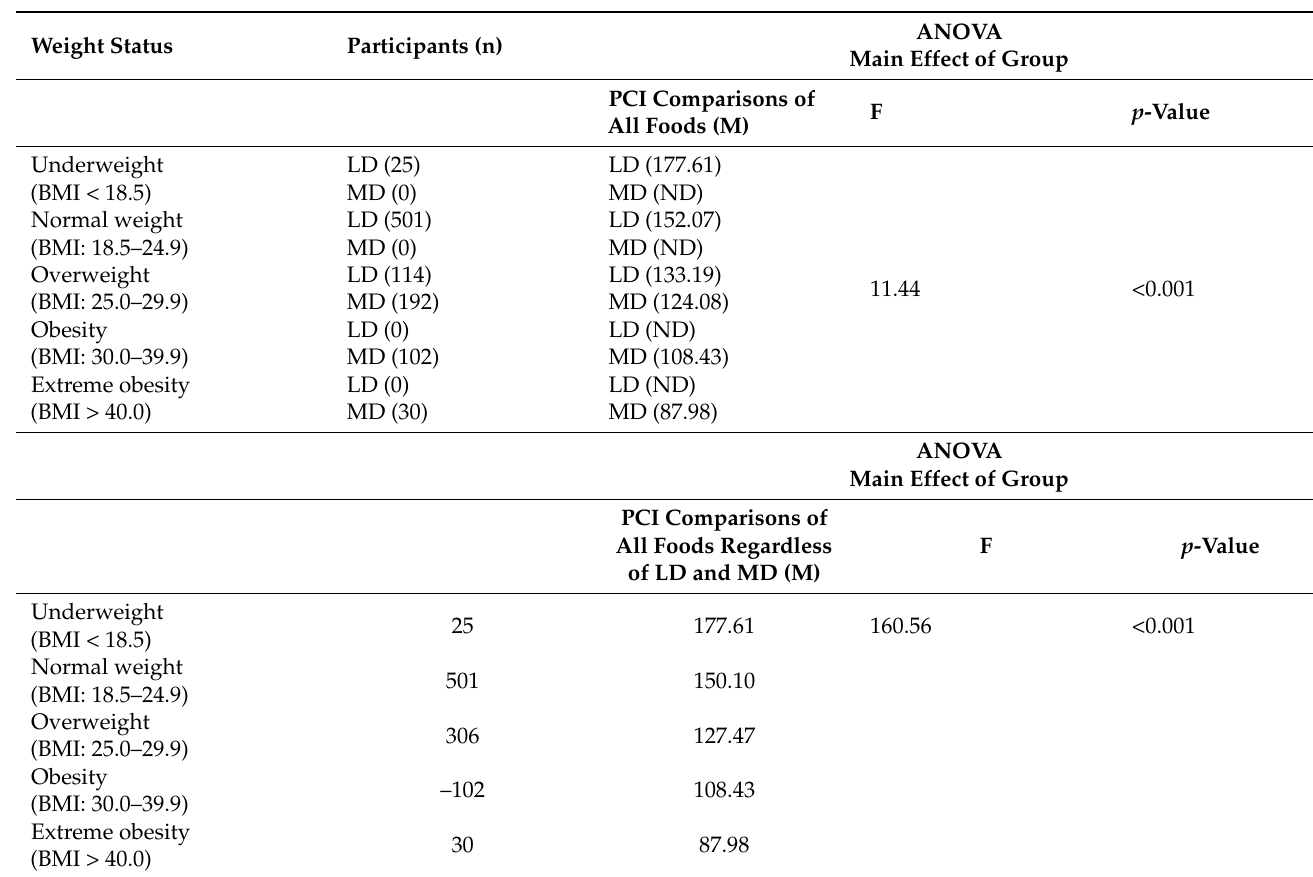
Table A4. Comparisons of PCIs of all foods between weight status and the LD and MD groups and regardless the LD and MD groups.